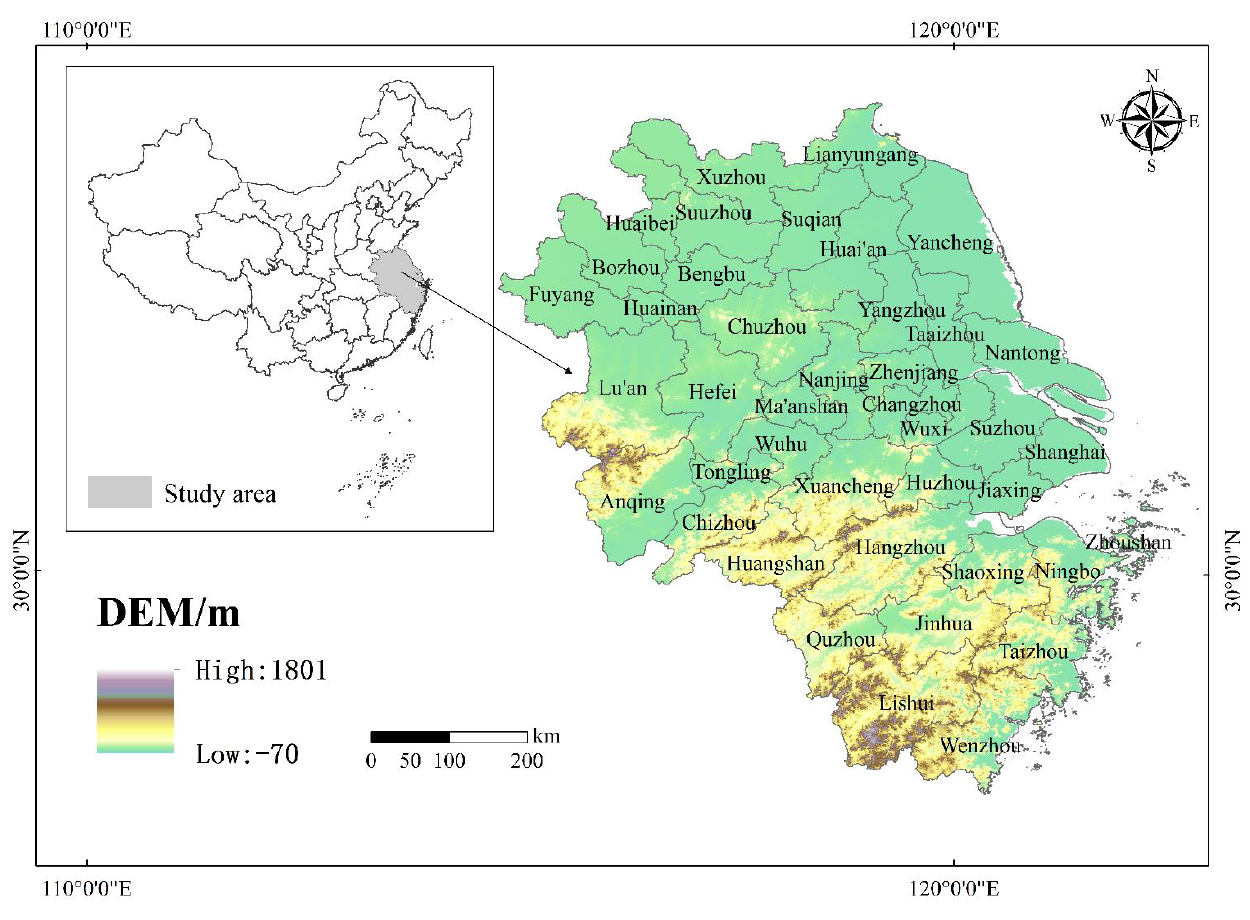
Figure 1. The location of the study area. Table 1. Evaluation indexes of the contribution rate of